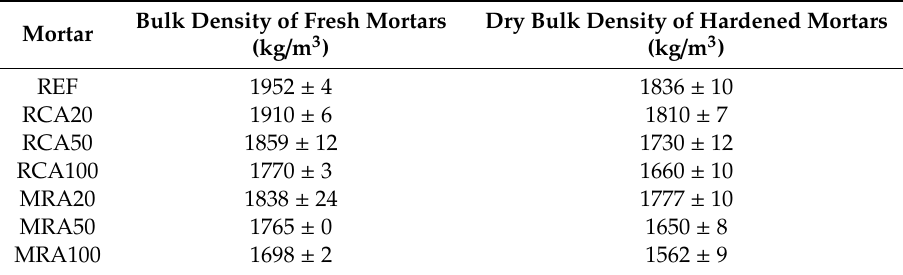
Table 6. Bulk density of the mortars (kg/m 3 ).